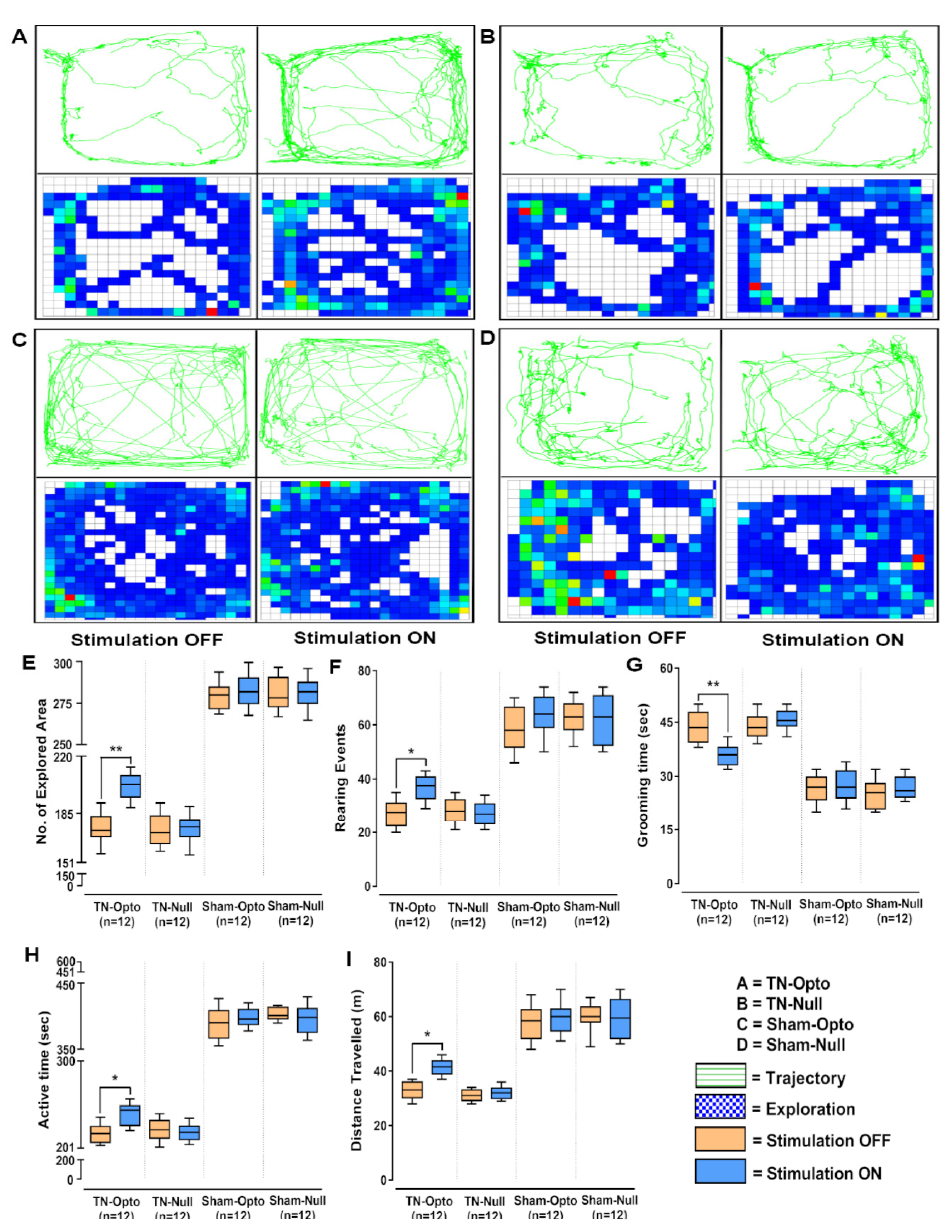
Figure 4. Alteration of behavioral responses in the open field test by optogenetic stimulation. ( A – D ) Trajectory and exploration representations of the TN-Opto, TN-Null, Sham-Opto, and Sham-Null groups, respectively, during stimulation “OFF” and “ON” conditions. ( E ) Numbers of explored areas, ( F ) rearing events, ( G ) grooming time, ( H ) active time, and ( I ) distance traveled. In all the behavioral paradigms, the TN-Opto group exhibited significant alterations with the stimulation “ON” condition but no significant changes in behavioral scores were observed in other animal groups with the stimulation “ON” condition. *, p < 0.05; **, p < 0.01, significant differences determined using unpaired t